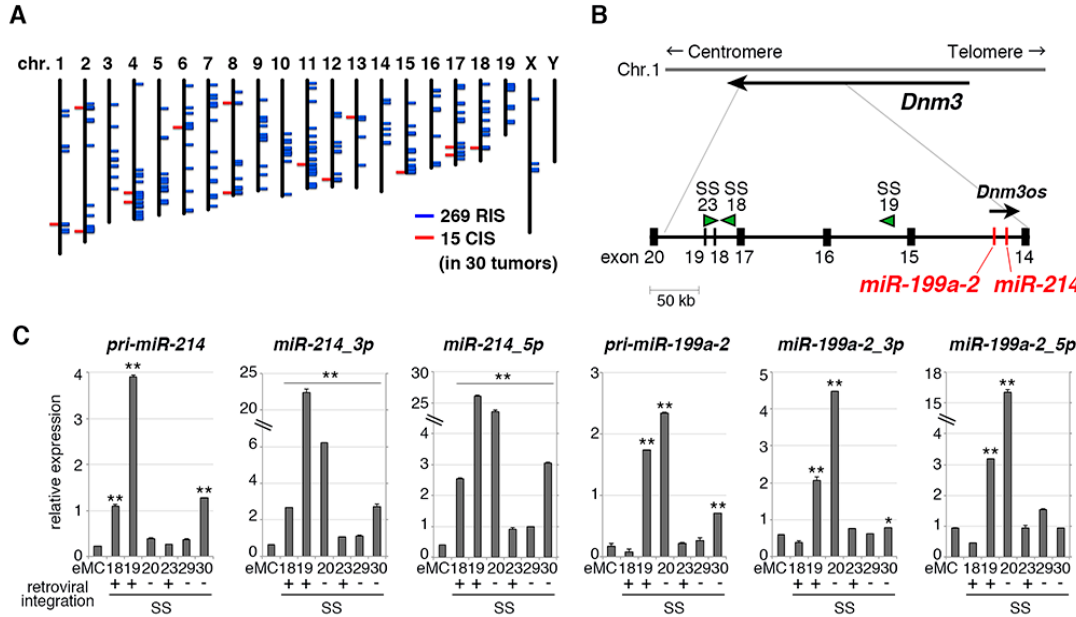
Figure 3. Identification of retroviral integration sites in mouse synovial sarcomas. ( A ) Distribution of 269 retroviral integration sites in 30 tumors on mouse chromosomes. Common integration sites are indicated with red lines, and single integration sites with blue lines. ( B ) Schematic of retroviral integrations at the Dnm3 locus. Each integration is marked with arrowheads with the directions also indicated. Genetic positions of Dnm3os , miR-214 , and miR-199a-2 are indicated. ( C ) RT-qPCR for pri-miR-214 , miR-214_3p , miR-214_5p , pri-miR-199a-2 , miR-199a-2_3p , and miR-199a-2_5p in synovial sarcomas with or without retroviral integrations. Expression values were normalized to snoRNA202 expression. * p < 0.05 and ** p <